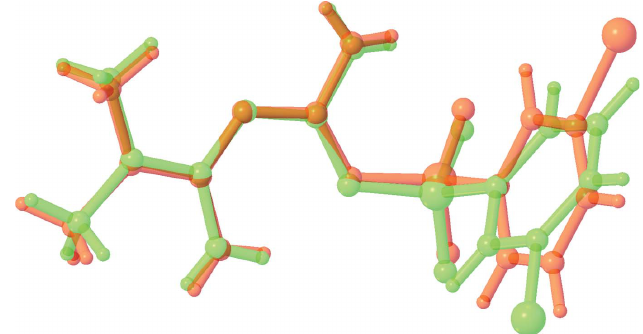
Figure 2 A view of the molecular fit of the A (green) and B (orange) molecules of the title compound (major component) calculated using the Overlay routine in OLEX2 (Dolomanov et al. , 2009).